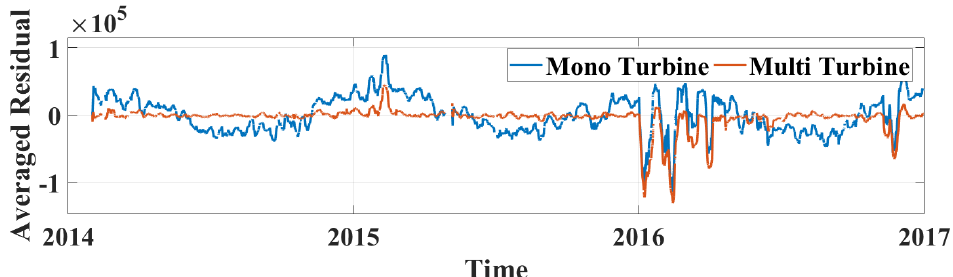
Figure 3. Examples of the averaged mono-turbine residual 𝑅 𝑚𝑜𝑛𝑜 and multi-turbine residual 𝑅 𝑚𝑢𝑙𝑡𝑖 for wind turbine 𝑖 . The moving averaged data set of 3 years shows 2 years of fault-free and 1 year of fault data detailed in later sections.